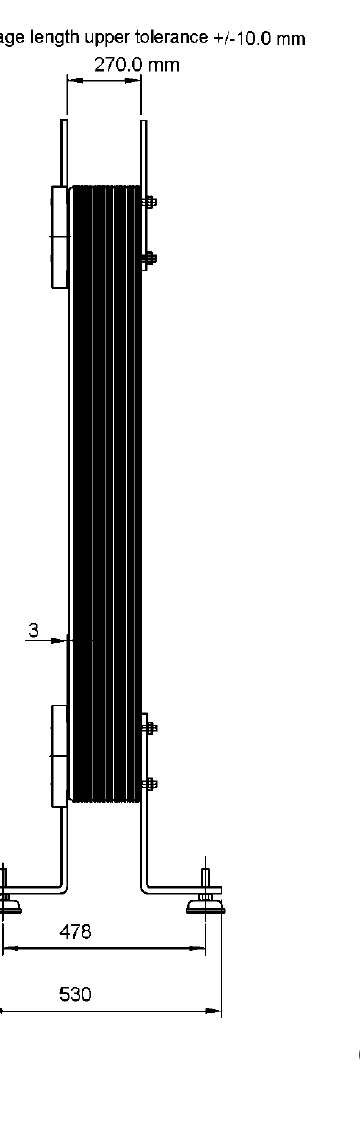
Figure 2. Detailed dimensions of the evaporators: ( a ) Plate heat exchanger; ( b ) Shell-and-tube heat